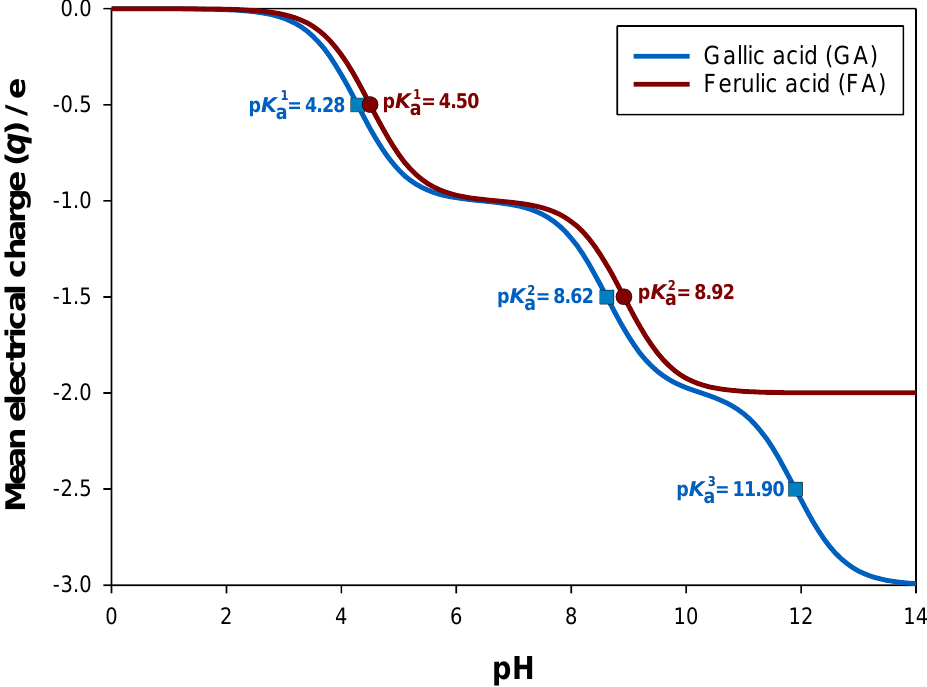
Figure 1. Calculated mean electrical charge ( q ) for gallic acid and ferulic acid, expressed in terms of the elementary charge (e), i.e., 1.602 · 10 − 19 C.